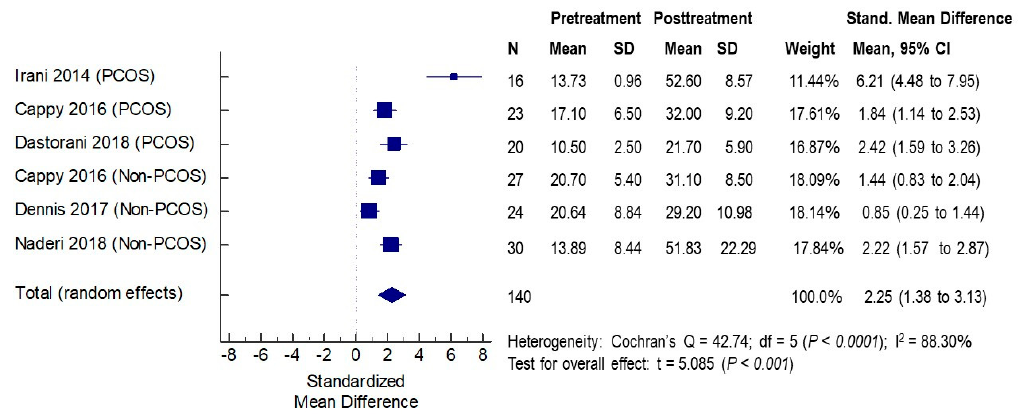
Figure 2. Effects of vitamin D supplementation on serum vitamin D levels. PCOS: polycystic ovarian syndrome. CI: confidence interval; df: degrees of freedom.